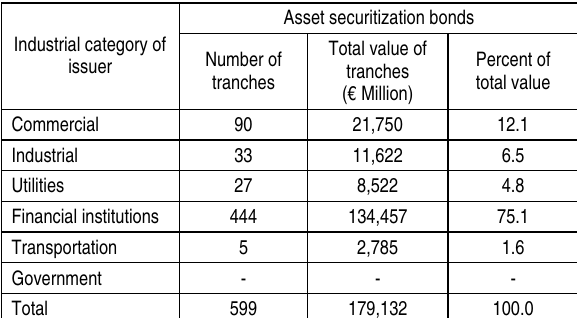
Table 2. Industrial distribution of asset